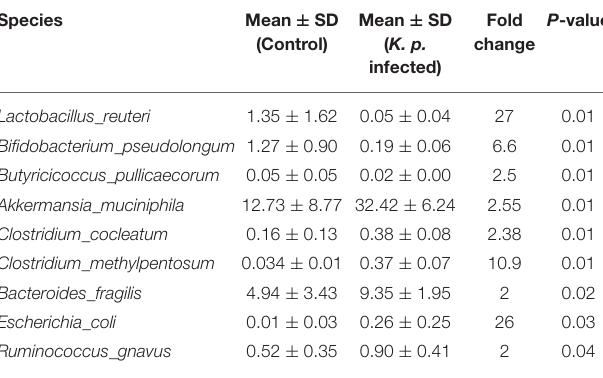
P -value Mean ± SD Fold (Control) ( K. p. change infected)